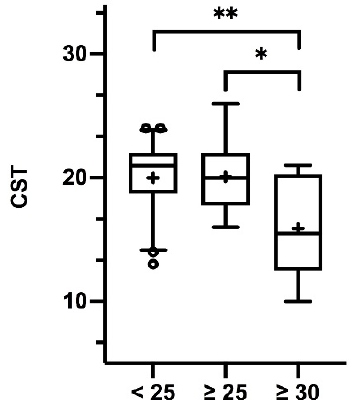
Figure 1. Box-and-whisker plots of retronasal olfactory test results (CST) per body mass index (BMI)